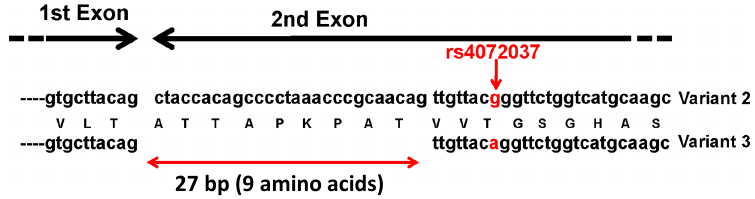
Figure 1. SNP (single nucleotide polymorphism) rs4072037 (G/A, red arrow) in the MUC1 gene determines the major splicing variants expressed in the gastric mucosa. In the gastric mucosa, major splicing forms were variants 2 and 3, and the allele of SNP rs4072037 is related to the splicing acceptor site selection in the second exon (1st and 2nd exons are indicated by black arrows) and consequently determines the variant type. The variant 2 but not the variant 3 transcript contains the first 27 bp (double-headed red arrow) of the 2nd exon.